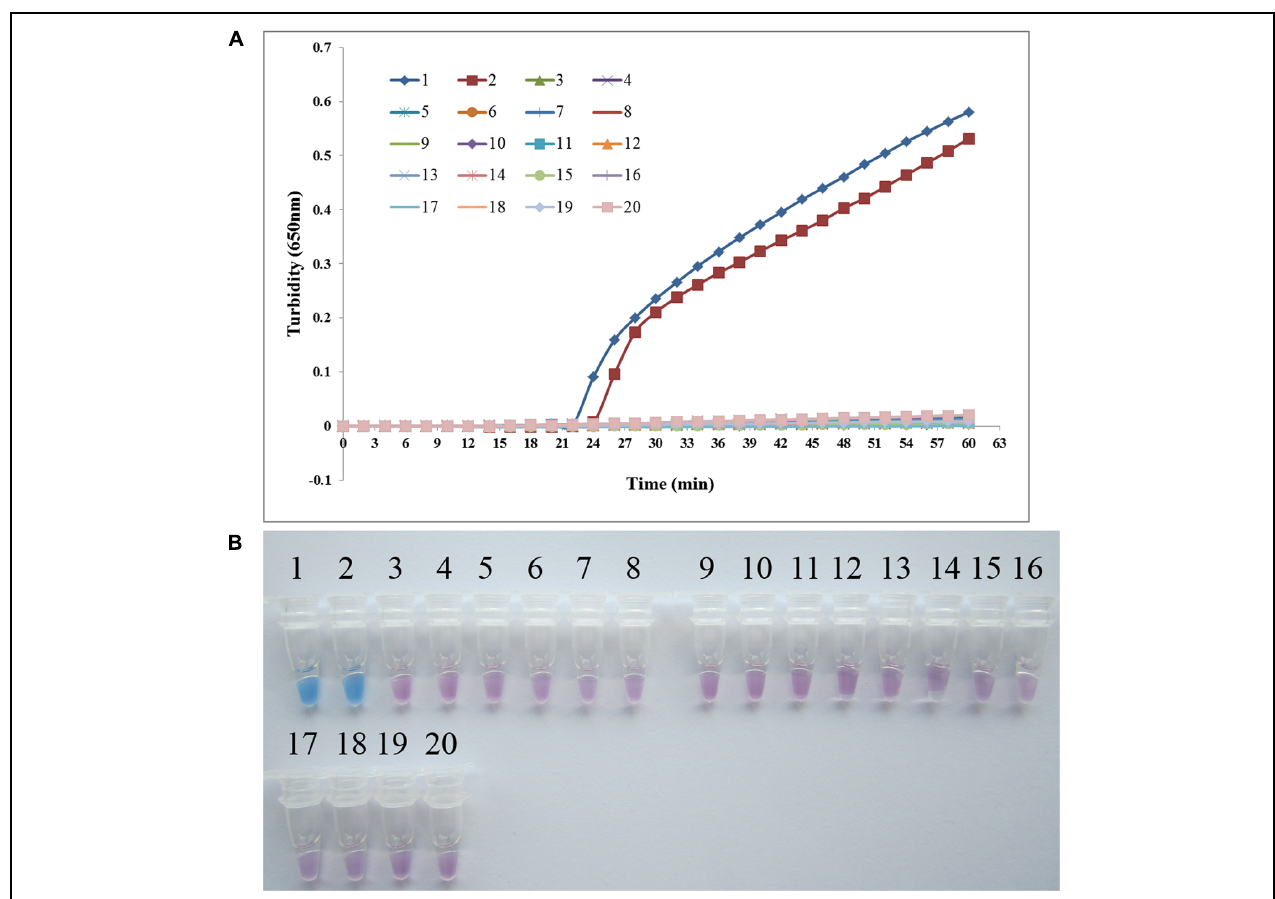
FIGURE 3 | PSR assay specificity. Specificity of the PSR method for detecting Pseudomonas aeruginosa by real-time turbidimeter (A) or HNB colorimetric assay (B) . Amplification was performed at 65 ◦ C for 60 min. 1, P. aeruginosa ATCC 15442; 2, P. aeruginosa CMCC 10539; 3, P. fluorescens CGMCC 1.1802; 4, Burkholderia pseudomallei 029; 5, P. geniculate CGMCC 1.871; 6, P. mendocina CGMCC 1.593; 7, P. putida 2309; 8, Klebsiella pneumoniae ATCC 2146; 9, Streptococcus pneumoniae 112-07; 10, Mycobacterium tuberculosis 005; 11, Staphylococcus aureus 2740; 12, Acinetobacter baumannii 12101; 13, Escherichia coli 44825; 14, Shigella flexneri 4536; 15, Stenotrophomonas maltophilia K279a; 16, Legionella pneumophila 9135; 17, Haemophilus influenza ATCC 49247; 18, Salmonella typhi 9275; 19, Proteus vulgaris CMCC 49027; 20, negative control (double distilled water).